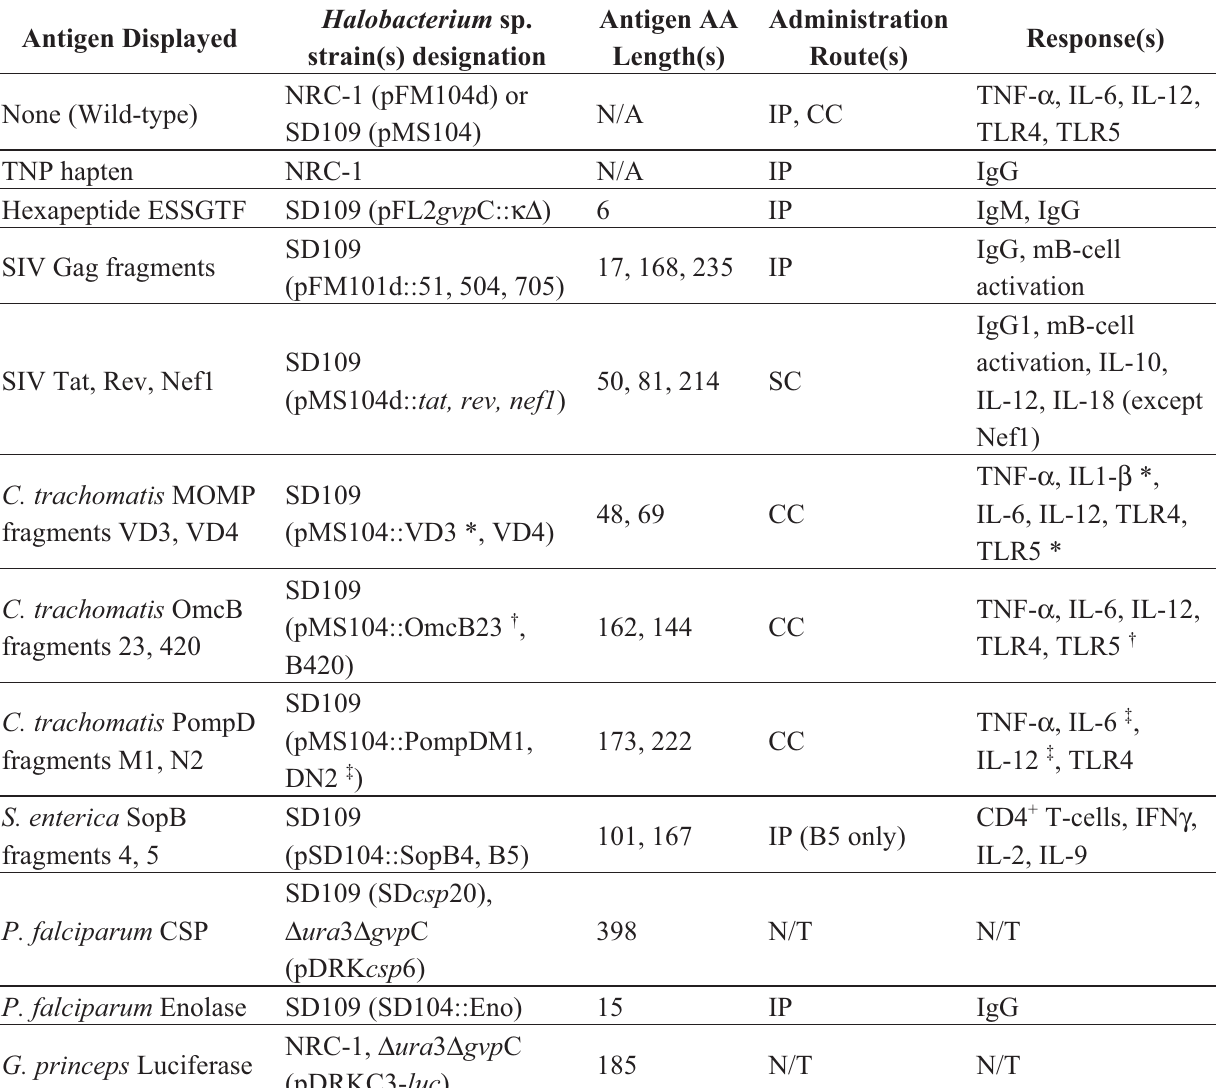
Table 2. Antigen display on GVNPs and immune